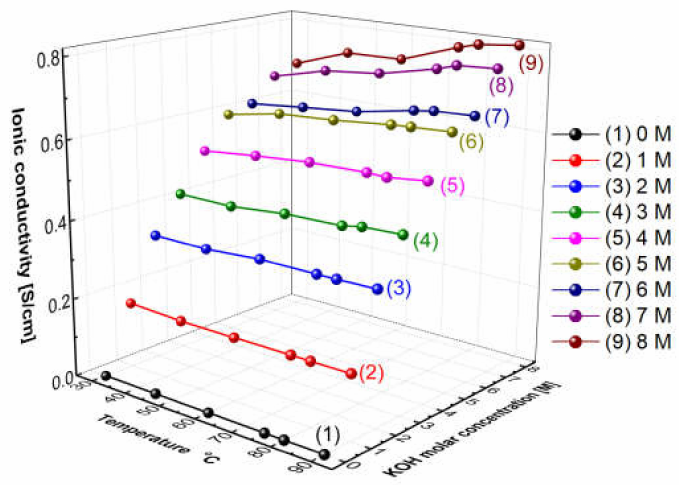
Figure 5. Hydroxide ion conductivity of aqueous KOH solutions as a function of temperature and concentrations.